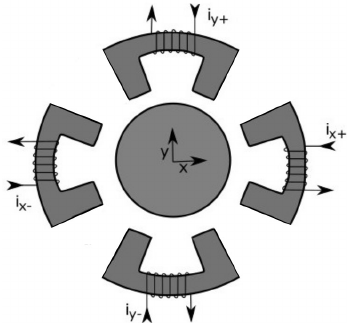
Figure 2. Classic radial four-phase AMB.